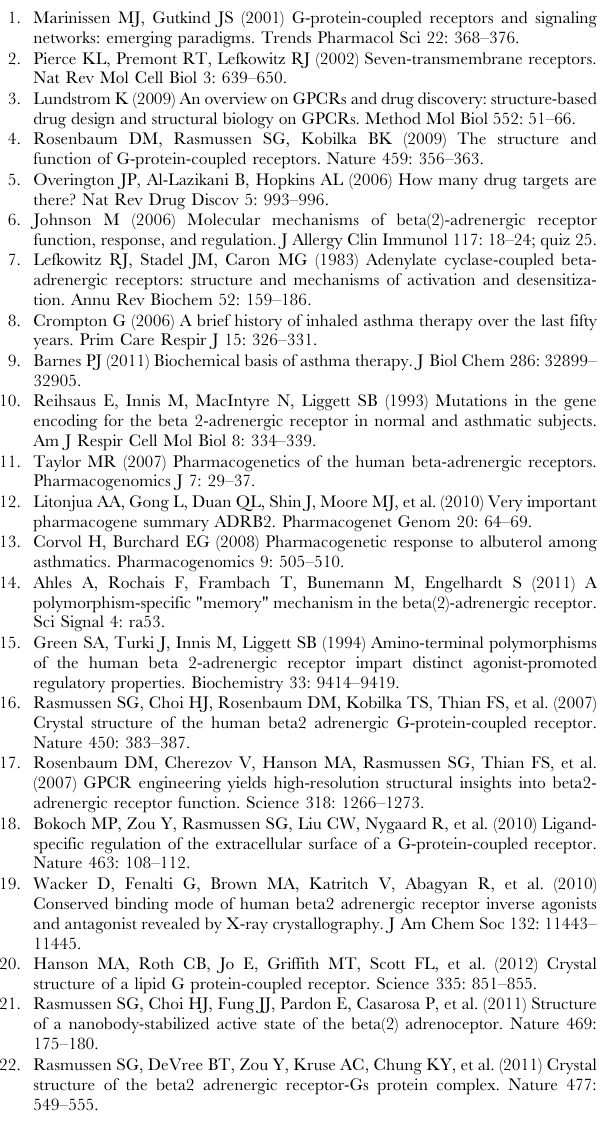
S9 Figure Characterization of additional homology models of the b 2 AR variants. Top-view snapshots of initial